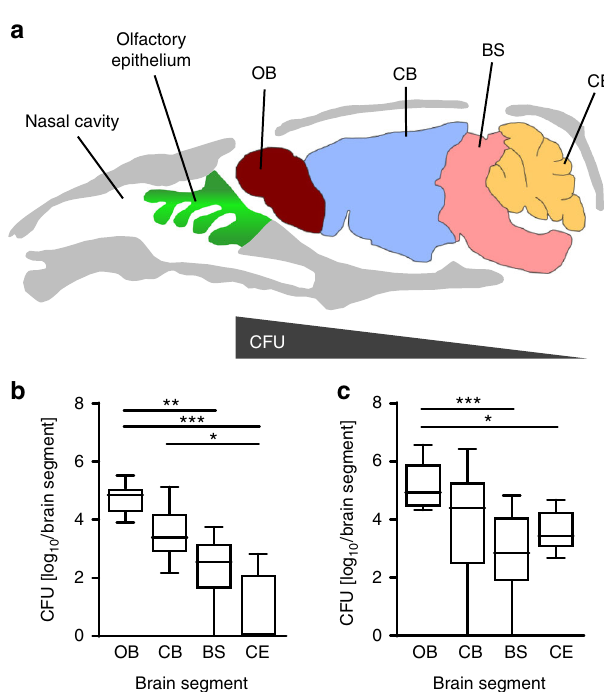
Fig. 2 Cerebral infection spreads along the rostro-caudal axis. a Sagittal section of a mouse skull with nasal cavity, olfactory epithelium and the different brain segments such as the olfactory bulb (OB), cerebrum (CB), brain stem (BS), and cerebellum (CE). b and c Bacterial counts in the respective brain segments of 1-day-old neonatal mice infected i.n. with 1 × 10 4 CFU Lm at 3 ( b ) and 5 ( c ) dpi. Total brain tissue was collected after transcardial perfusion and dissected into OB, CB, BS, and CE as indicated. The Data set at 3 dpi is derived from n = 8 and at 5 dpi derived from n = 10 pups. Box and whisker; median and 5 – 95 percentile. One-way ANOVA Kruskal-Wallis with Dunnets ’ post test; * p < 0.05; ** p < 0.01; *** p <